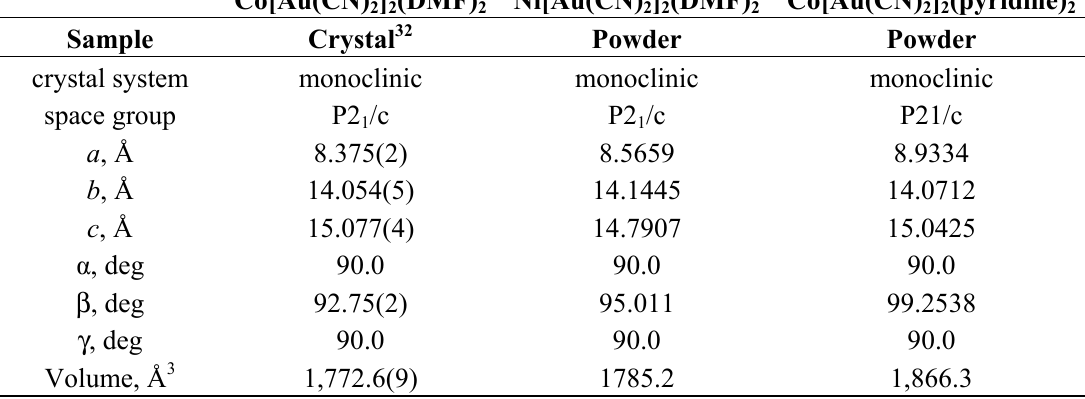
] (DMF) (M = Co, Ni) 2 2 2